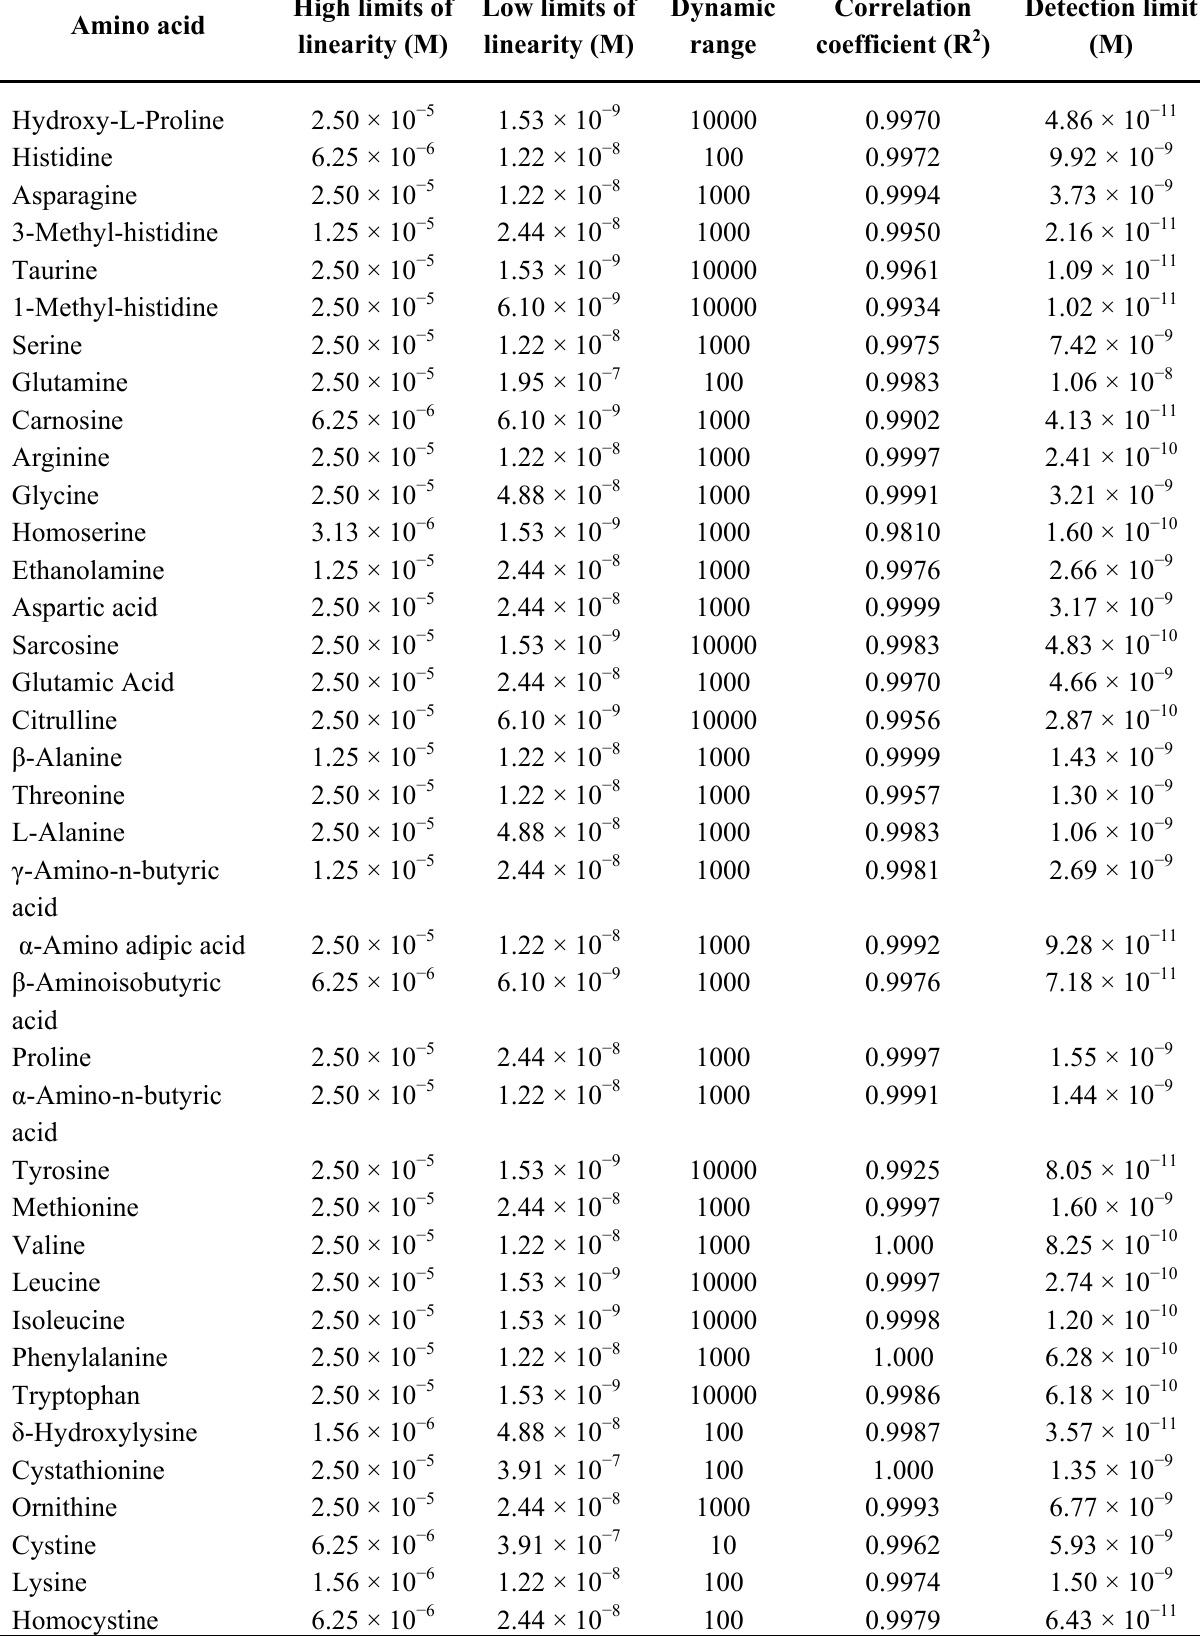
Table 3. Evaluation results for linearity and sensitivity of UPLC-ESI-MS/MS method for the analysis of AQC-derivatized amino